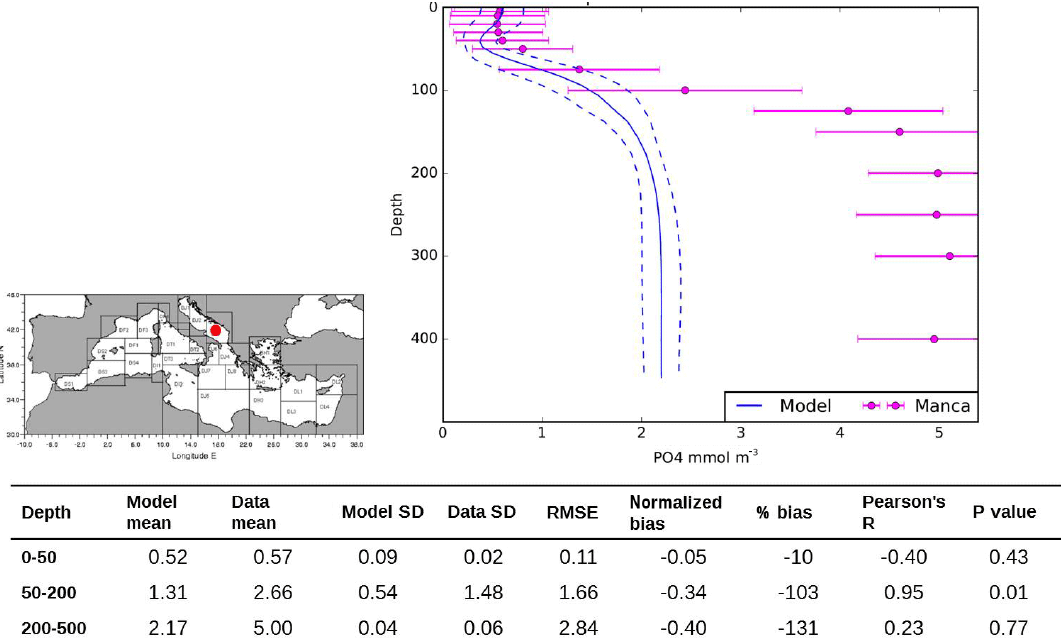
Figure A9. Annually averaged NO 3 vertical profile in the south Adriatic sub-basin (see map and Manca et al., 2004) and statistical indicators over different depth. Model values are shown with the blue line (2005 average, Ntot simulation from Richon et al., 2017) and measured values from Manca et al. (2004) are in pink. Horizontal bars and dashed lines indicate the spatial SD of observations and model results respectively.